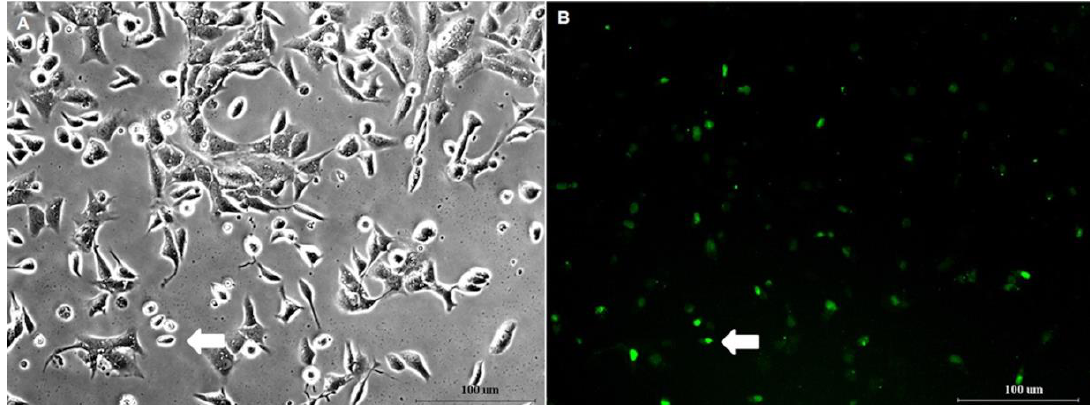
Figure A1. ( A ) SKOV-3 cells under fluorescence microscope (phase contrast), x200. ( B ) SKOV-3 cells under fluorescence microscope (FITC), x200. Green fluorecein (arrow) indicates miR-141 inhibitor successfully transfected into the cell. Transfection efficiency was between 60 – 70%.